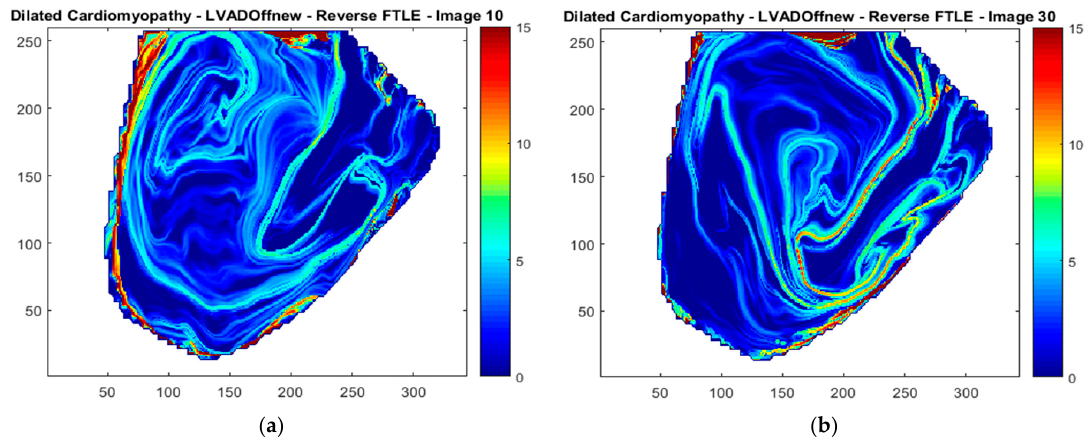
Figure 3. Attracting LCS surfaces are extracted from the Reverse FTLE fields to illustrate the E and A waves through the mitral valve during diastolic filling. ( a ) E wave ; ( b ) A wave .